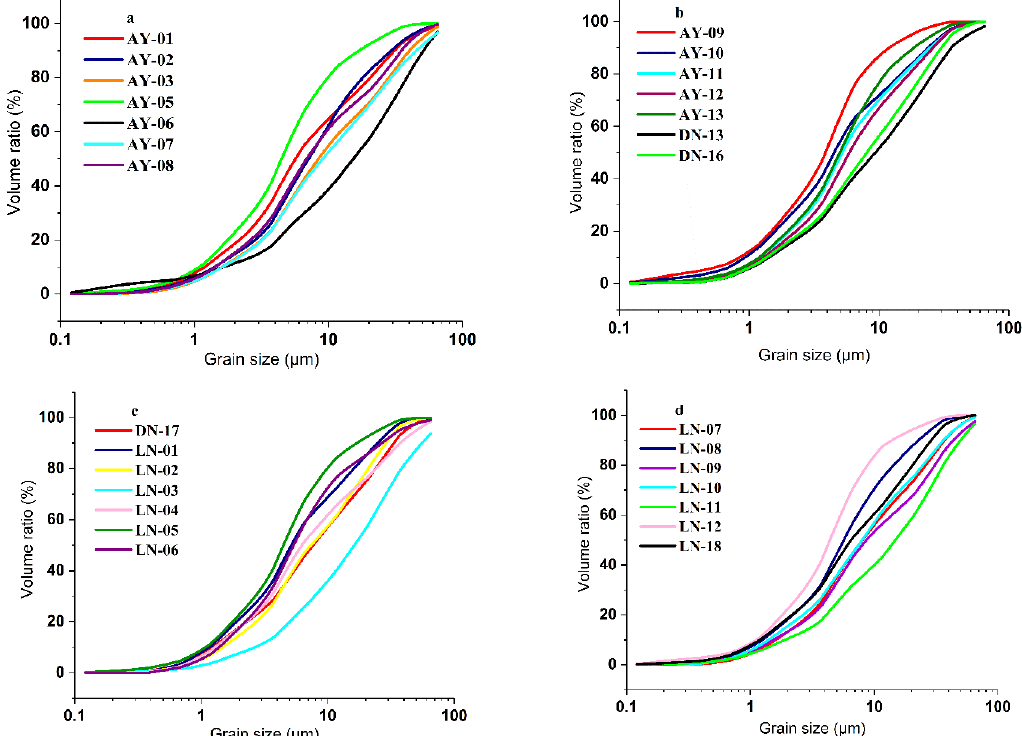
Figure 3. Cumulative particle size distribution curves from ion-absorbed RE in (regional samples). ( a ) shows the curves with AY-01, AY-02, AY-03, AY-05, AY-06, AY-07 and AY-08; ( b ) shows the curves with AY-09, AY-10, AY-11, AY-12, AY-13, DN-13 and DN-16; ( c ) shows the curves with DN-17, LN-01, LN-02,LN-03, LN-04, LN-05 and LN-06; ( d ) shows the curves with LN-07, LN-08, LN-09, LN-10, LN-11, LN-12 and LN-18.